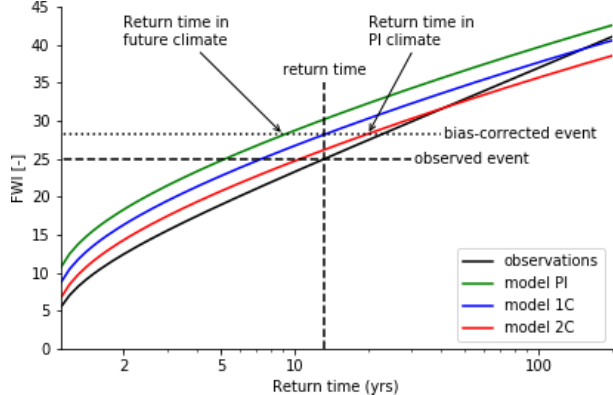
Figure 3. Schematic of the bias correction